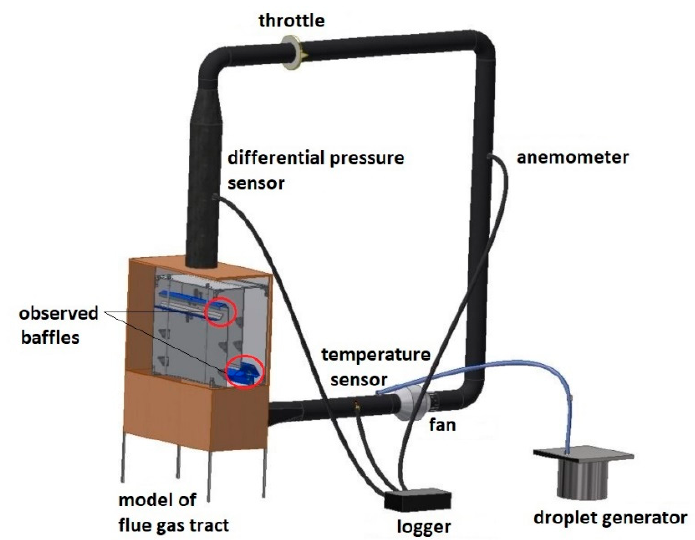
Figure 3. The experimental set-up.